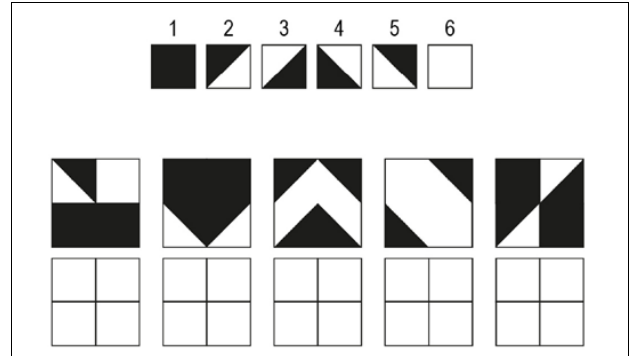
FIGURE 2 | An example of the Design Organization Test (DOT). The task is to reproduce the pattern shown in the square grid using the numerical code given at the top. The participant was instructed to fill out the empty squares at the bottom with the number associated with each piece of the pattern. Extracted and modulated from Killgore et al.